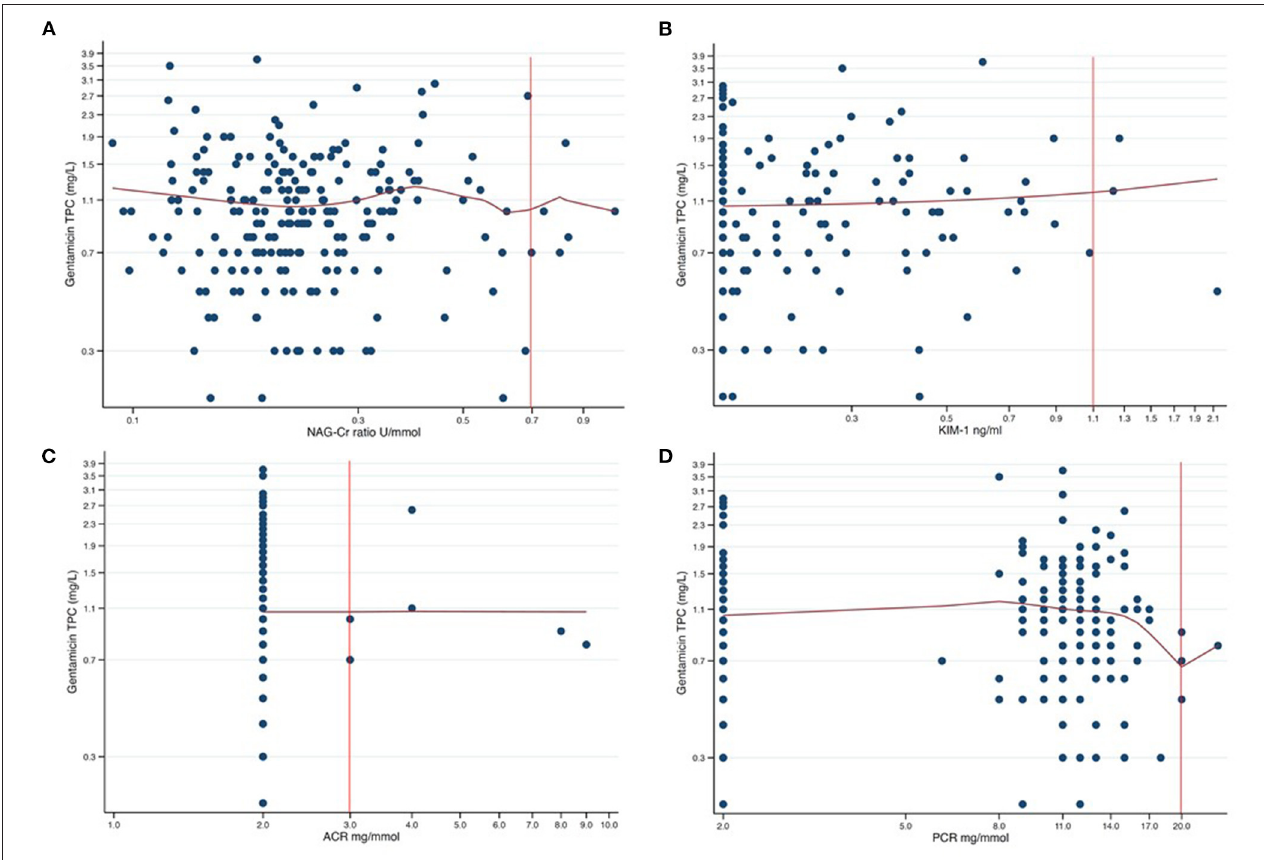
FIGURE 3 | Scatter plots of gentamicin trough plasma concentration (TPC) against each of the four assessed urine biomarkers presented in a log-log graph. The red curves are the results from non-parametric kernel regression for the relationship between the gentamicin TPC and the urine biomarkers. The y-axis shows the gentamicin TPC in mg/L with 0.4 mg/L between axis ticks in each of the plots. The tick markers for the x-axes are evenly spaced but appear unevenly spaced since the axes are logarithmic. The distance between axes ticks is chosen so that, in each plot, one tick marker coincides with the cut-off value (red vertical line). (A) NAG-Cr (U/mmol) on a logarithm scale, with the distance between the tick markers for the x-axis of 0.2 U/mmol. (B) KIM-1 (ng/ml) on a logarithm scale, with the distance between the tick markers for the x-axis of 0.2ng/ml. (C) ACR (mg/mmol) on a logarithm scale, with the distance between the tick markers for the x-axis of 1.0 mg/mmol. (D) PCR (mg/mmol) on a logarithm scale, with the distance between the tick markers for the x-axis of 3.0